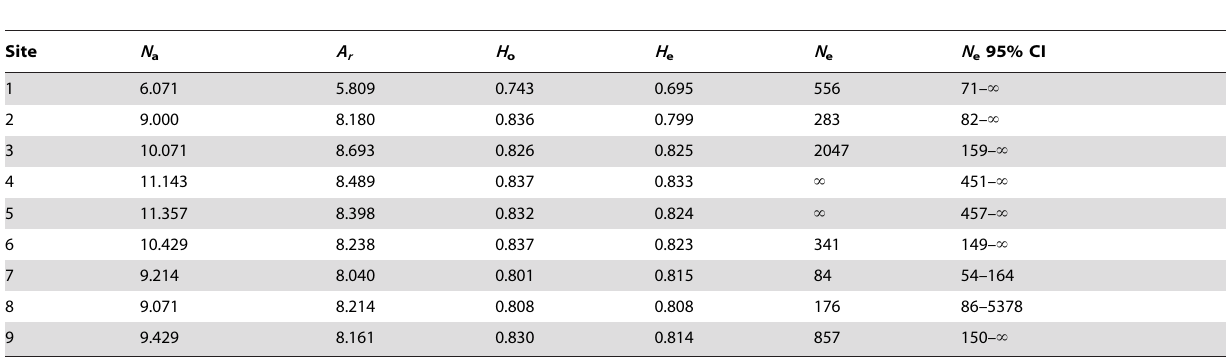
Table 3. Summary population genetic characteristics and estimated effective population size ( N e ) of the nine sampled populations.